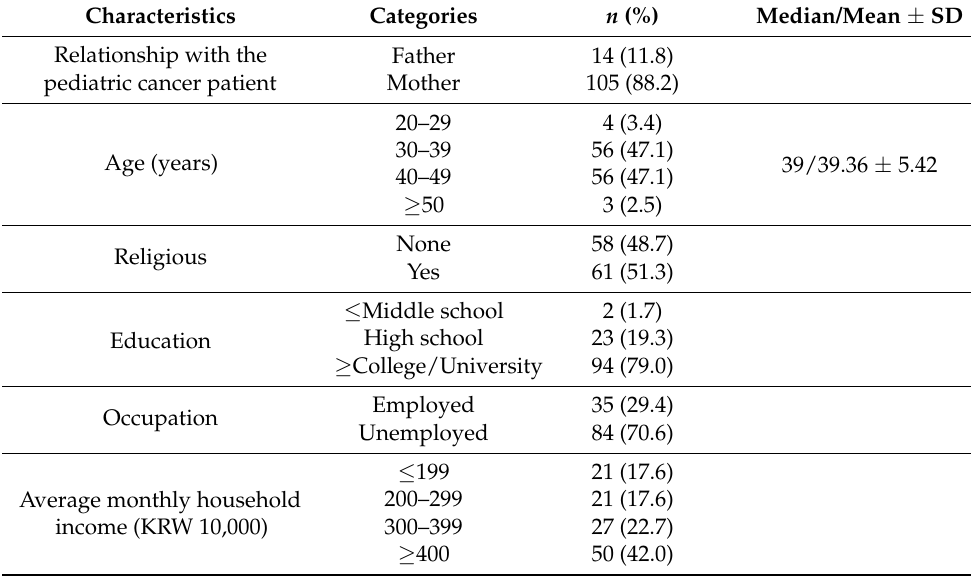
Table 1. Demographic characteristics of the participants ( n = 119).